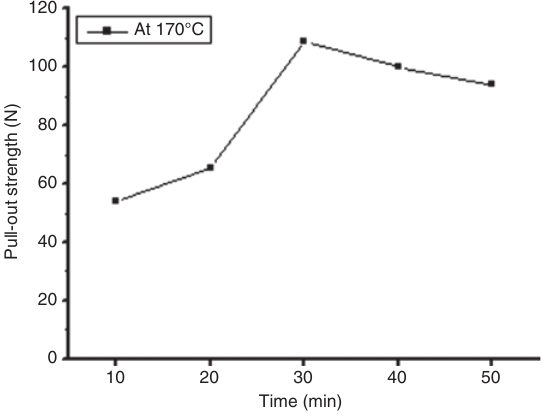
Figure 2: Pull-out curve of tire cord-reinforced CR at 170 ° C for various vulcanization durations.